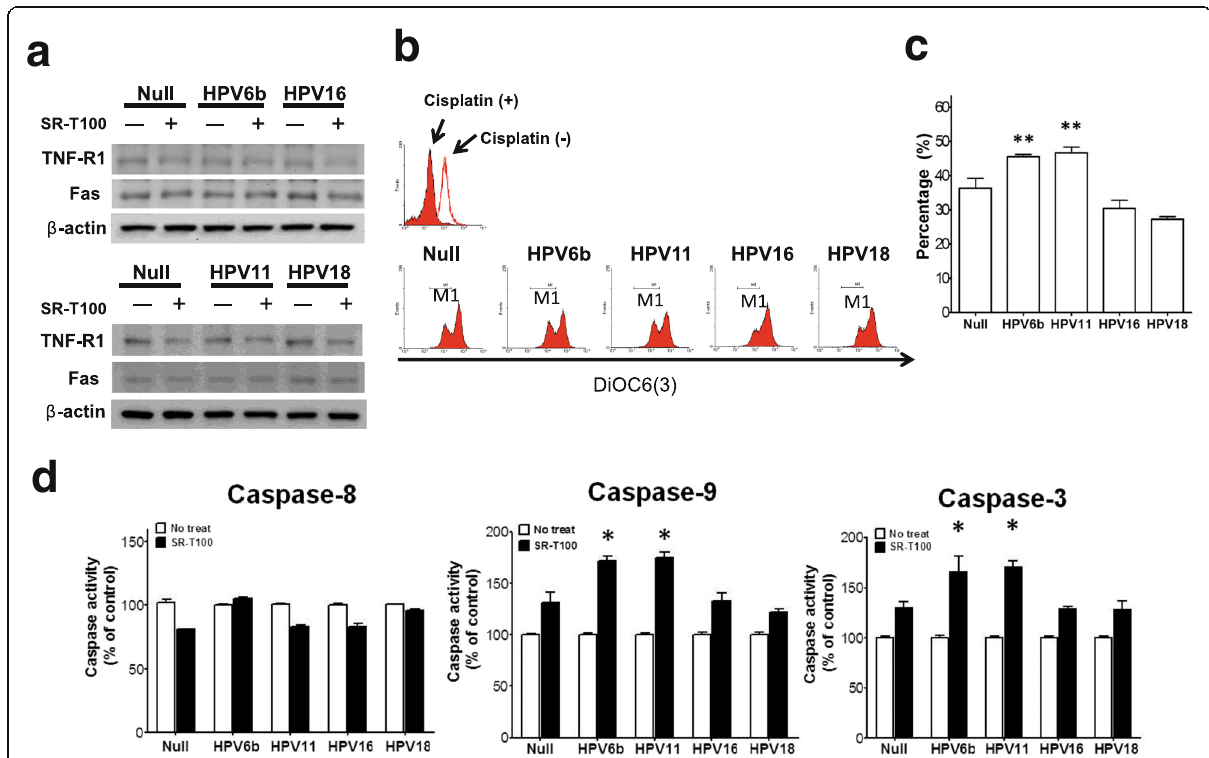
Fig. 2 SR-T100 induced mitochondria-dependent apoptosis in primary epithelial cells expressing different types of HPV-E6/E7. a The apoptotic- associated proteins TNF-R1 and Fas were detected by western blot. Lysates were collected after the cells were infected with the Lenti-HPV6b-E6/ E7, Lenti-HPV11-E6/E7, Lenti-HPV16-E6/E7 and Lenti-HPV18-E6/E7 viruses and treated with or without SR-T100 (5 μ g/ml) for 12 h. Note that the TNF-R1 and Fas expression levels did not increase after SR-T100 treatment. b SR-T100 reduced MMP. Primary epithelial cells expressing different types of HPV-E6/E7 were treated with SR-T100 (5 μ g/ml) for 12 h (lower panel) and stained with DiOC6(3) to measure MMP by flow cytometry. HeLa cells that had been treated with cisplatin (150 μ M) for 24 h (upper panel) were used as the positive control. c Histograms of low-DiOC6(3) fluorescence-gated (M1) cells expressing different types of HPV-E6/E7. The data represent the mean ± SD of three independent experiments. ** p < 0.01, HPV6b or HPV11 versus HPV16 or HPV18. d SR-T100 induced caspase-9 and -3 activation but not caspase-8 activation. Caspases-3, − 8, and − 9